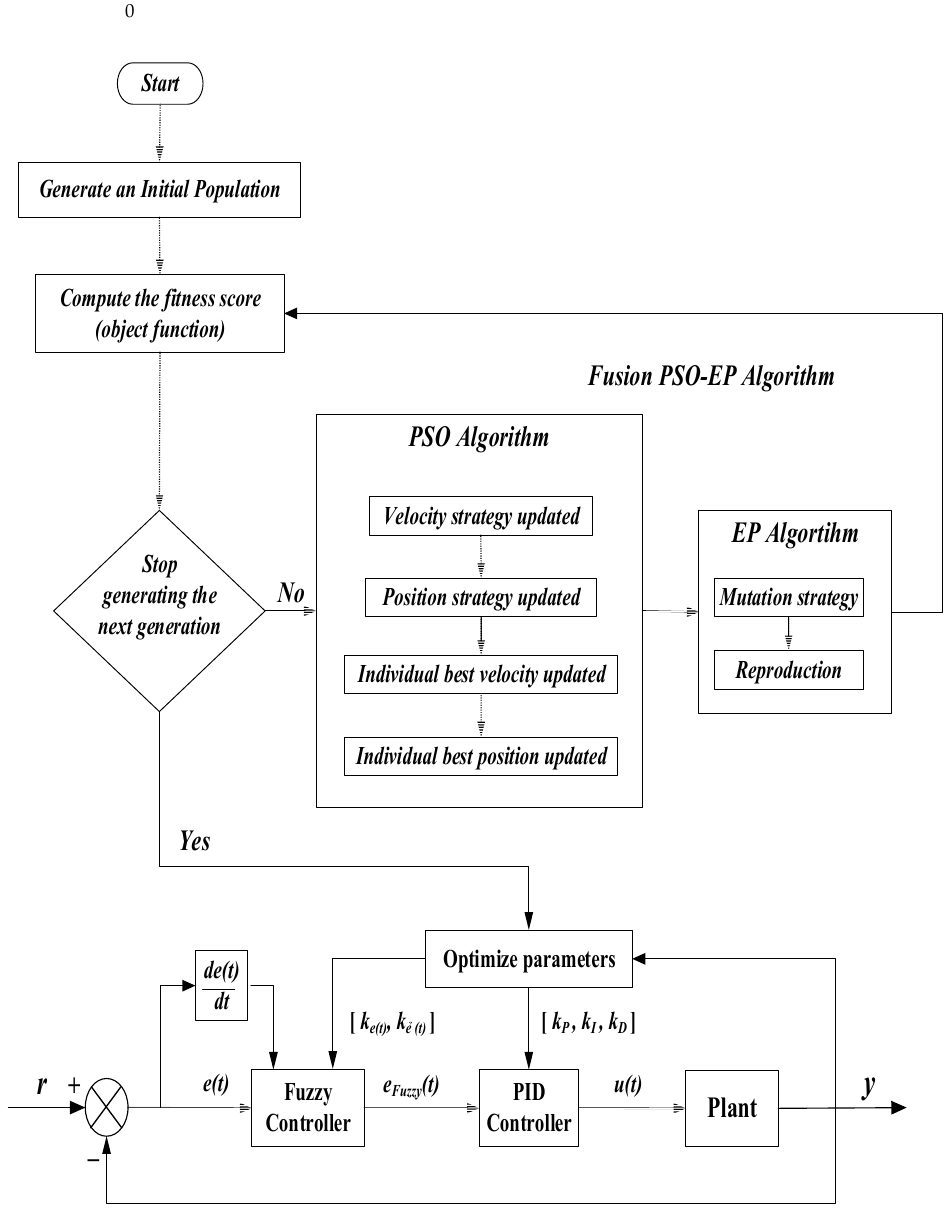
Figure 2. Fusion particle swarm optimization–evolutionary programming (PSO–EP) algorithm and reinforced fuzzy-PID (proportional integral derivative) controllers.